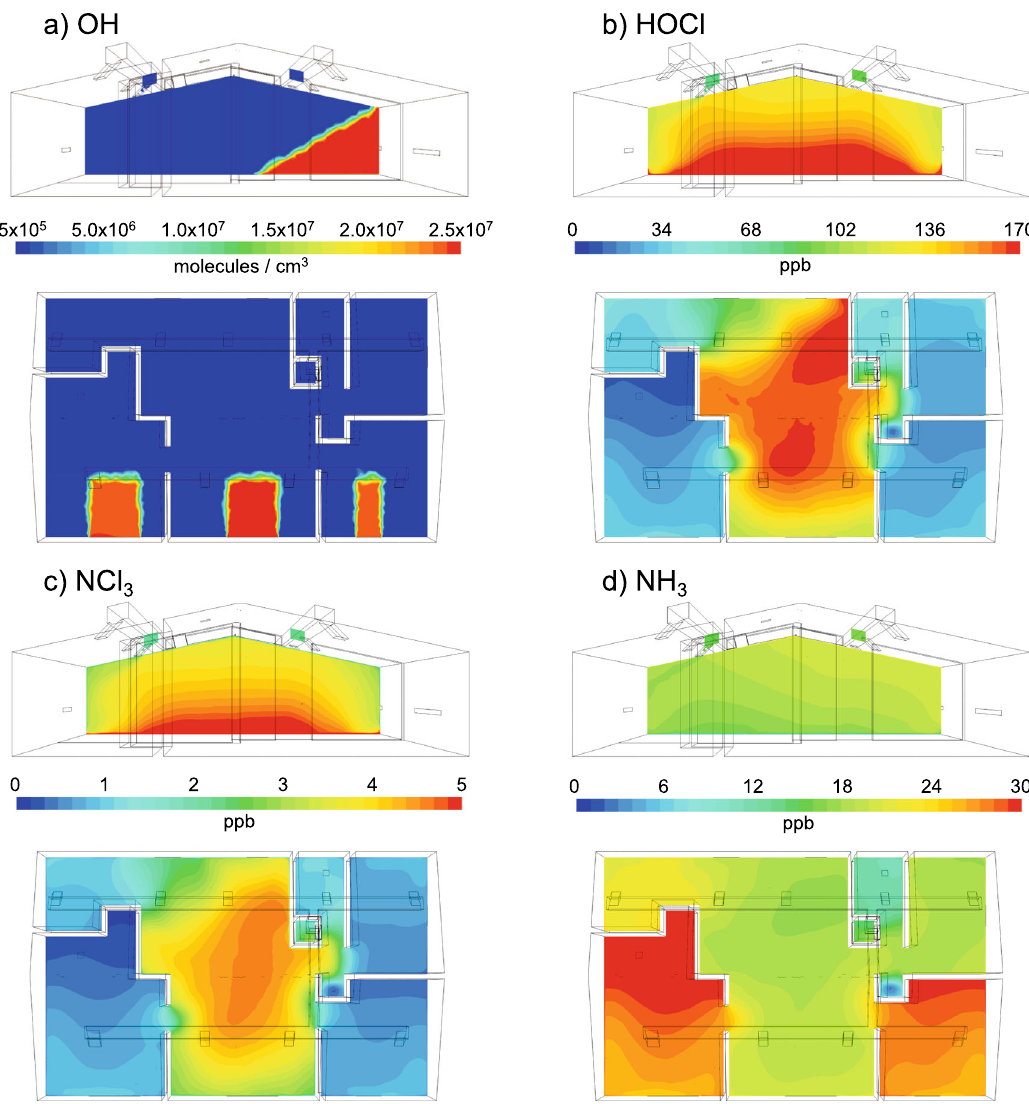
Fig. 2 Spatial distributions of bleach products. Horizontal and vertical spatial distributions of ( a ) OH, ( b ) HOCl, ( c ) NCl 3 , and ( d ) NH 3 at 18 min after the beginning of the cleaning. Horizontal maps represent 1.5 m above the fl oor and vertical maps represent sections with the red line in Fig.